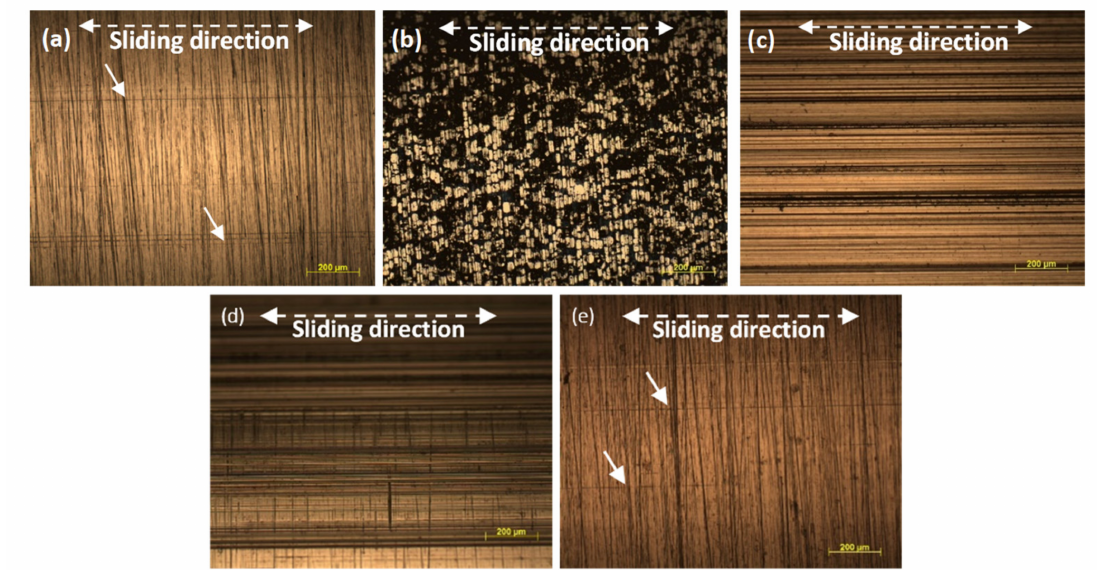
Figure 9. Wear track on ( a ) hard Cr reference, ( b ) Cr variant and Ni variants: ( c ) I, ( d ) II and ( e ) III coated rods after sliding against anodized Al rods under lubricated conditions.